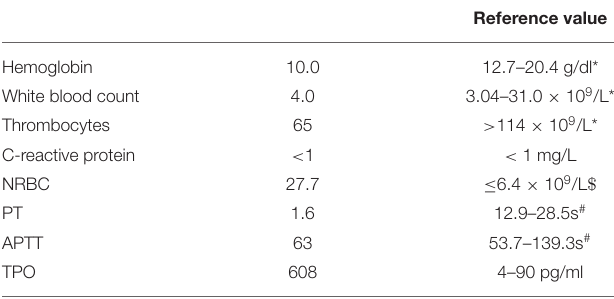
TABLE 3 | Laboratory results